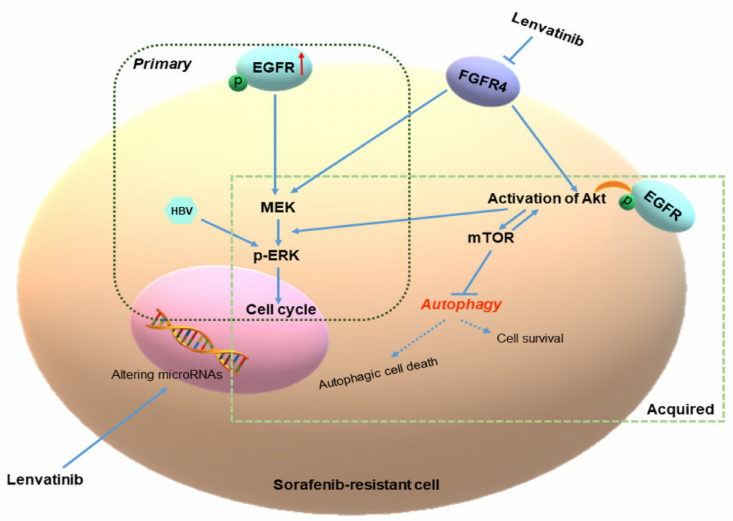
Figure 9. Proposed model for the underlying mechanism of lenvatinib in overcoming sorafenib resistance. Overexpression of EGFR leads to the activation of ERK and Akt signaling to induce sorafenib resistance and promote sorafenib-resistant cell proliferation. The underlying advantage of lenvatinib is the inhibition of FGFR4 compared with sorafenib. Huh-7SR and Hep-3BSR cells have high FGFR4 expression and the FGFR4-ERK signaling pathway is the major pathway to overcome increased EGFR-induced ERK activation. Compared with Huh-7SR cells, Hep-3BSR cells showed poor autophagic responsiveness to lenvatinib, which may contribute to their partial cross-resistance to